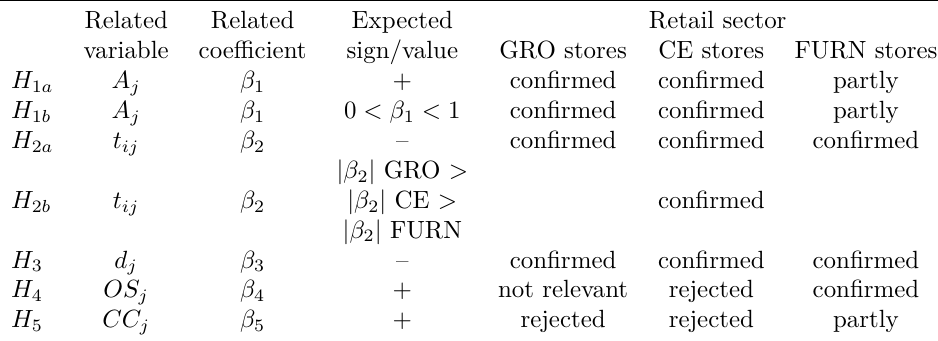
Table 10: Hypothesis tests by retail